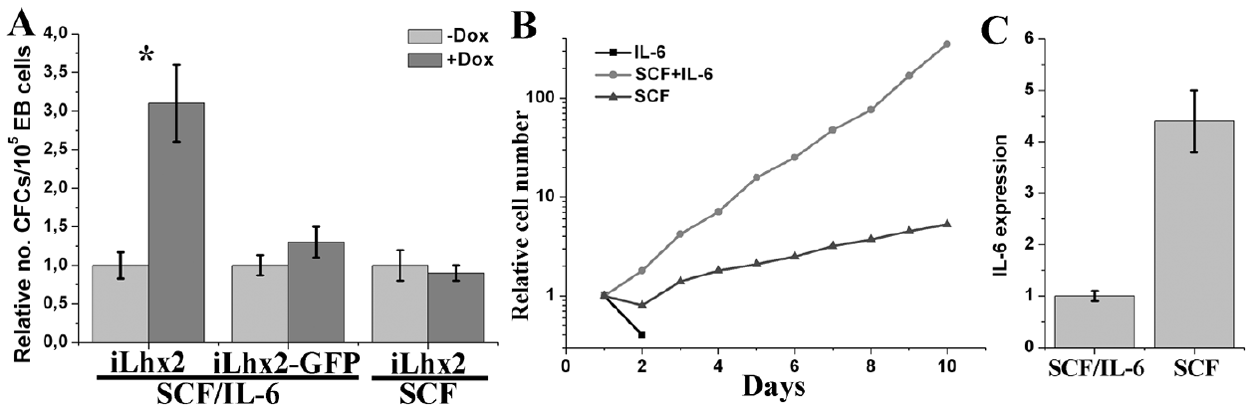
Figure 4. The efficiency in generating DoxHPC lines directly correlates to the synergistic effect of Lhx2 expression on colony formation, and the generation and maintenance of the DoxHPC lines is optimal in SCF/IL-6. A. Summary of the synergistic effect of Lhx2 expression ( + Dox) on definitive hematopoietic colony formation of EB cells generated from the iLhx2 ES cells (high level of Lhx2 expression in 2 m g/ ml of dox) or iLhx2-GFP ES cells (intermediate level of Lhx2 expression in 2 m g/ml of dox) replated in SCF/IL-6, or EB cells generated from the iLhx2 ES cells replated in SCF alone. * p , 0,0001. B. Relative growth of a DoxHPC lines cultured in either IL-6, SCF/IL-6, or SCF. C. Relative expression of IL-6 analysed by real-time PCR comparing a DoxHPC line cultured either in SCF/IL-6 or in SCF for 8 days.